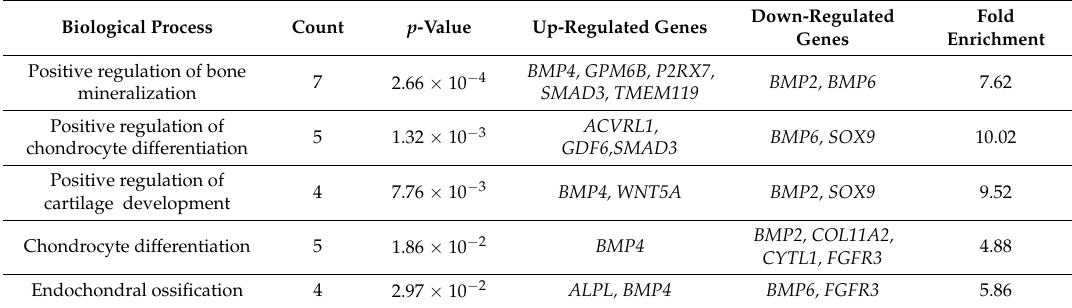
Table 2. Selected biological functions related to cellular, tissue and structural changes in